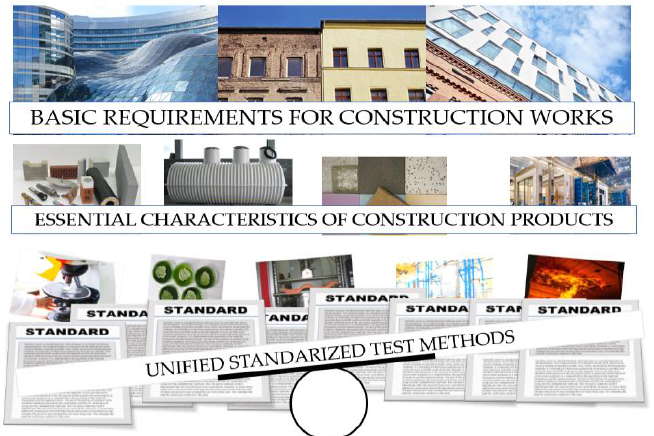
Figure 1. The base of the construction product assessment system, i.e., standardised test methods, can sometimes seem unstable.